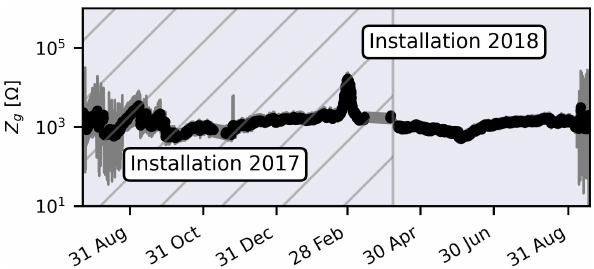
Figure 9. Evolution of mean contact resistances for all current injections at 1kHz. Grey areas indicate minimum and maximum